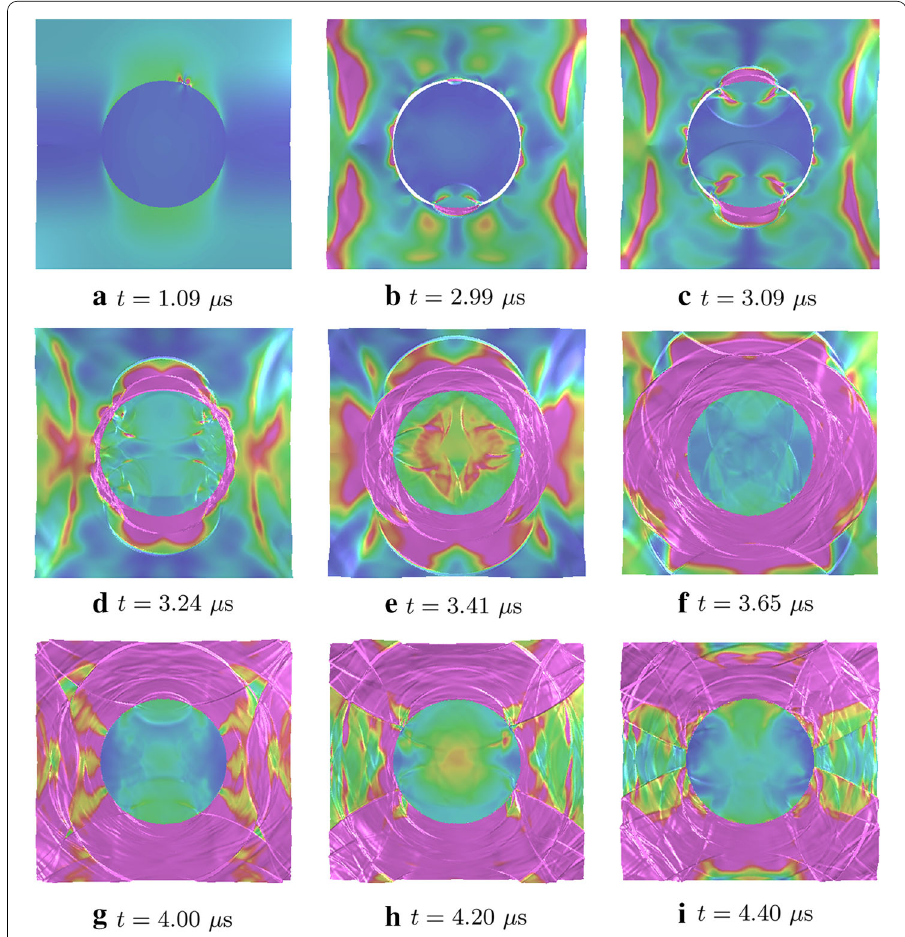
Fig. 6 Solution visualizations for circular inclusion in a square plate subjected to cyclic loading